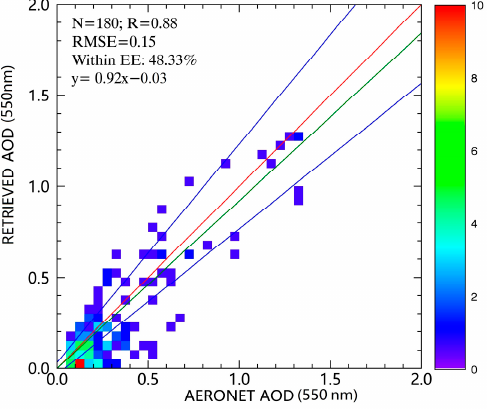
Figure 5. Comparison Between MODIS DB AOD and AOD Measured by AERONET Stations. 5. Research on the Pixel Scale of AOD Results with Different Resolutions In the process of using the SRAP algorithm to retrieve AOD, we noticed that there is a scale conversion problem between pixels when high-resolution AOD is resampled to a lower resolution. For example, when the retrieved 100 m AOD is resampled to 10 km for validation with MODIS DB AOD products, the single-pixel value of the resampled high- resolution AOD is not completely equivalent to the corresponding pixel value of 10 km MODIS DB AOD. Therefore, we discuss the scale relationship of AOD products with dif- ferent resolutions, mainly to explore the pixel scale between the AOD products released by NASA and the high-resolution AOD products retrieved in this paper.